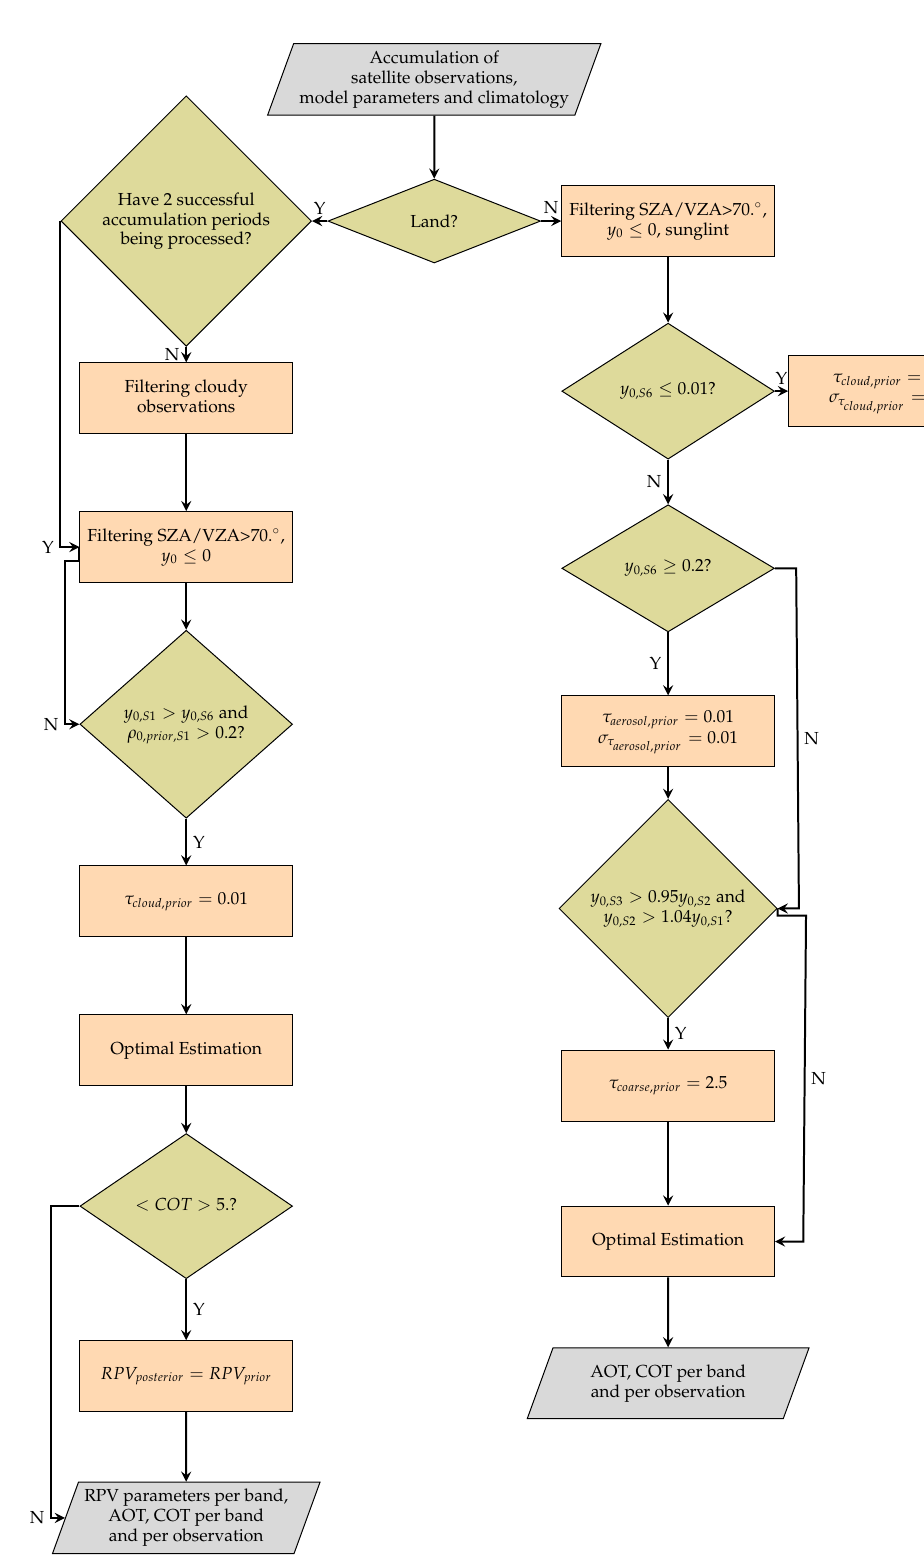
Figure 6. Flowchart of CISAR inversion of one accumulation